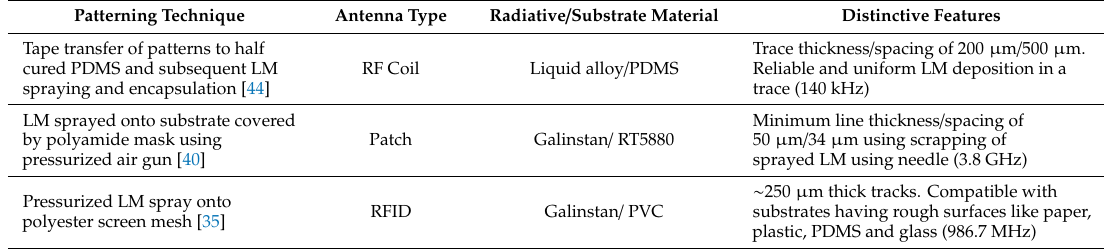
Table 4. LM Antenna patterning techniques based on fabrication methods involving LM spraying. Patterning Technique